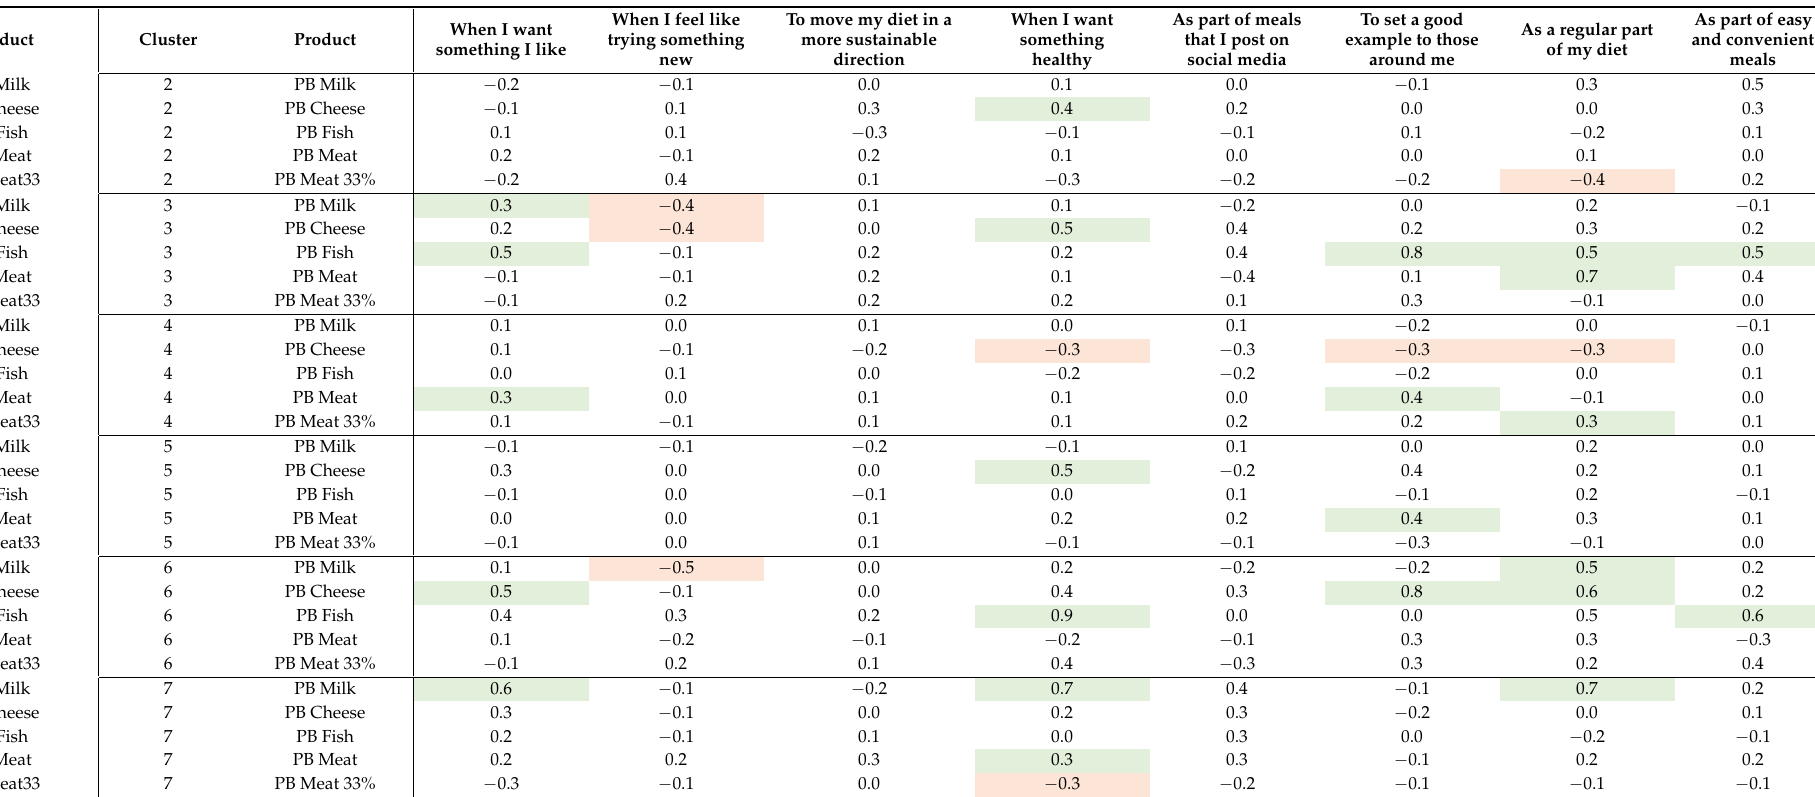
Table 4. Results following Penalty/Lift analysis for PB food categories in each of the six plant-based (PB) category discriminating clusters (Cluster 2 to Cluster 7), showing situational use drivers of willingness to consume